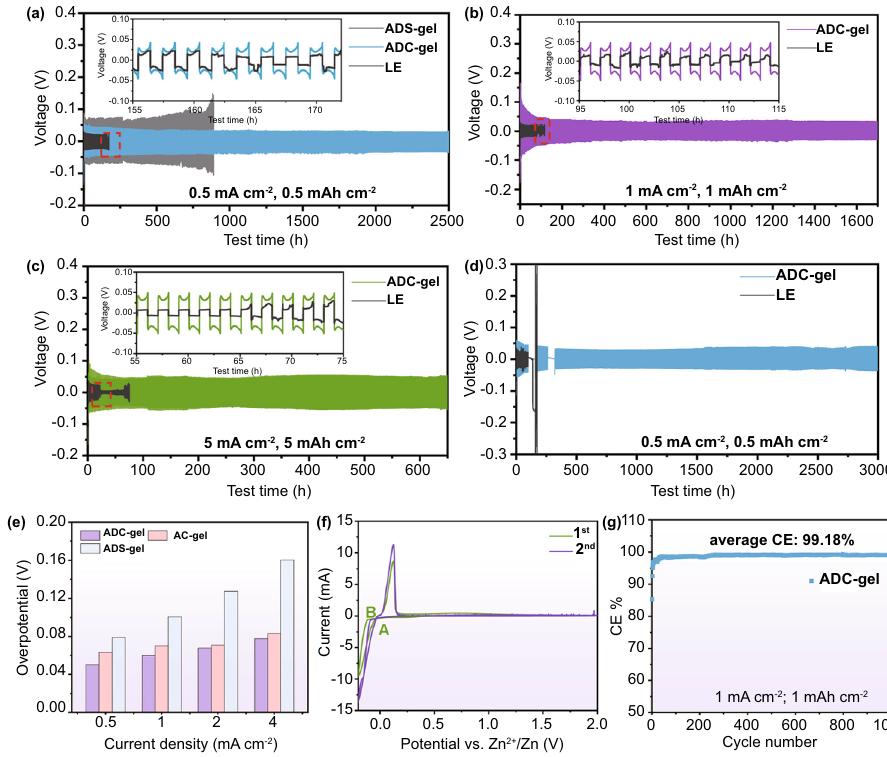
Fig. 3 Cyclic stability of symmetrical cells assembled with ADC-gel and liquid electrolytes under current densities and capacities of a 0.5 mA cm −2 , 0.5 mAh cm −2 , b 1 mA cm −2 , 1 mAh cm −2 and c 5 mA cm −2 , 5 mAh cm −2 . d Shelving performance of Zn//Zn symmetrical cells at 0.5 mA cm −2 , 0.5 mAh cm −2 . e Overpotential profile with different current densities (0.5, 1, 2 and 4 mA cm −2 ). f CV curves of Zn anode dis- solution and deposition in Zn/ADC-gel/stain steel cell at the scan rate of 0.5 mV s −1 . g CE curve of ADC-gel electrolyte in Zn//Cu asymmetric cell at 1 mA cm −2 , 1 mAh cm